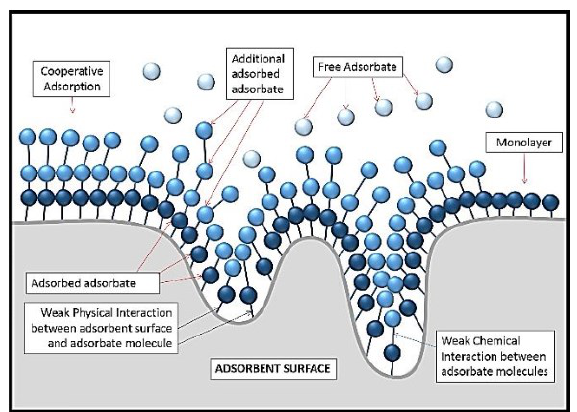
Fig. 4. Prediction model for adsorption process in silica from rice husk, adopted from the literature